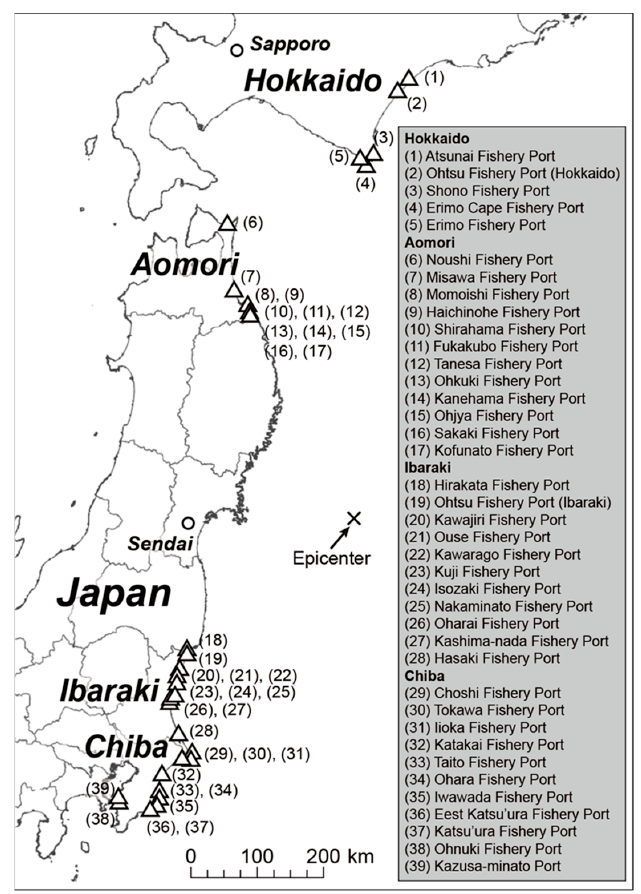
Figure 1. Surveyed fishery ports; the triangles indicate the ports we investigated. The numbers in parentheses indicate the name of the fishery port in the key on the right side. The × marks the epicenter of the 2011 Tohoku-oki earthquake.